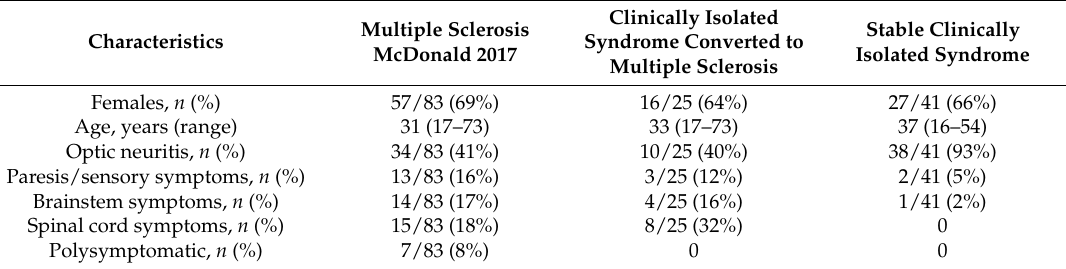
Table 1. Patient demographic and clinical